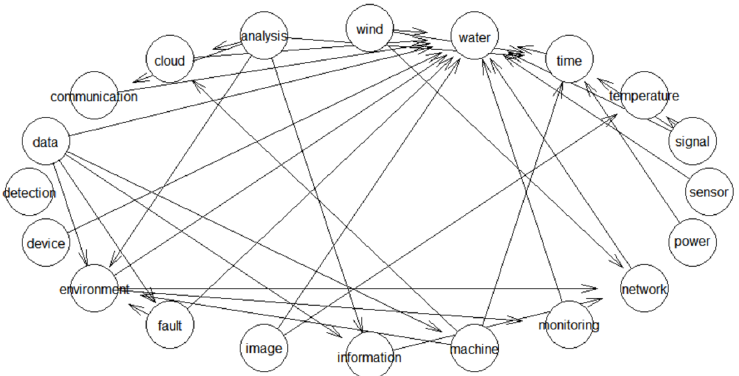
Figure 5. Bayesian visualization by a construct learning algorithm based on score.